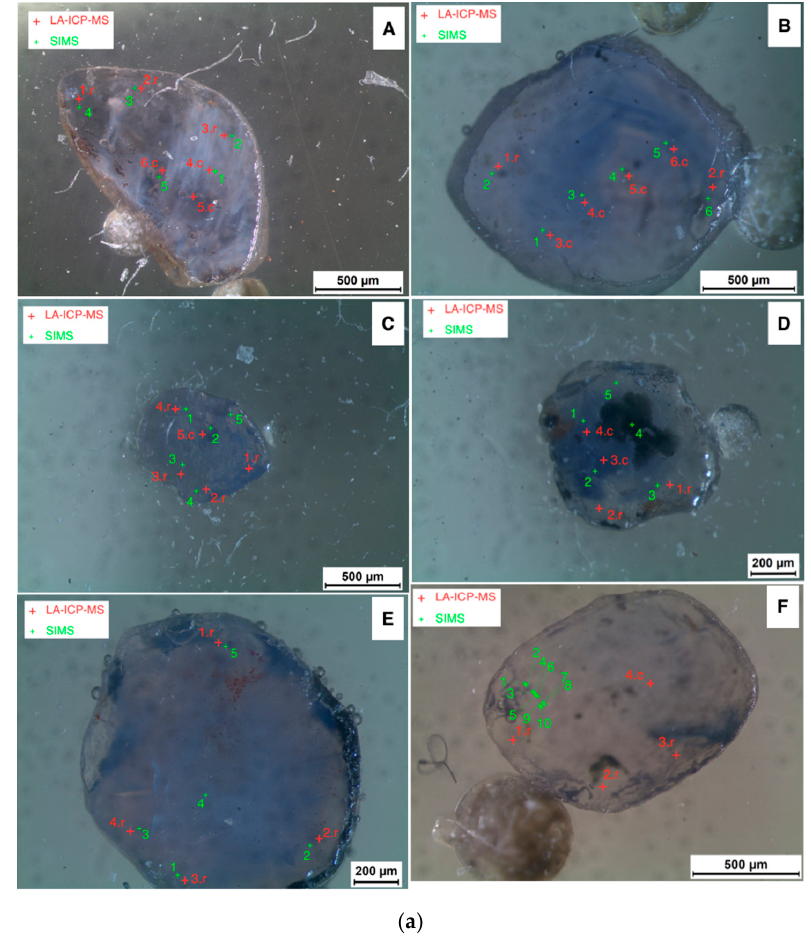
Figure 2. Images of the analyzed sapphires with both LA–ICP–MS and SIMS analysis spots indicated ( a ). A = AC-1, B = AC-2, C = AC-3, D = AC-4, E = AC-5 and F = AC-7. ( b ) A = AC-10, B = AC-11, C = AC-13, D = AC-14, E = AC-15 and F = AC-16).